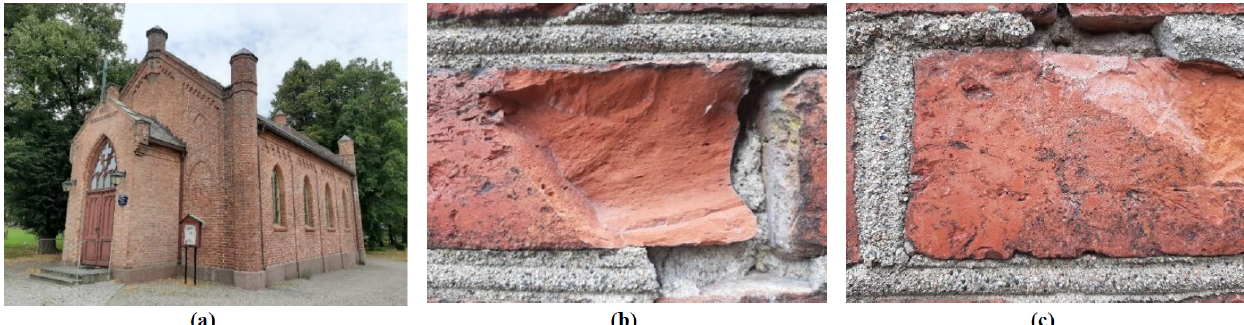
Figure 3. (a) Mary’s Chapel and (b) , (c) degraded bricks at its southeast oriented